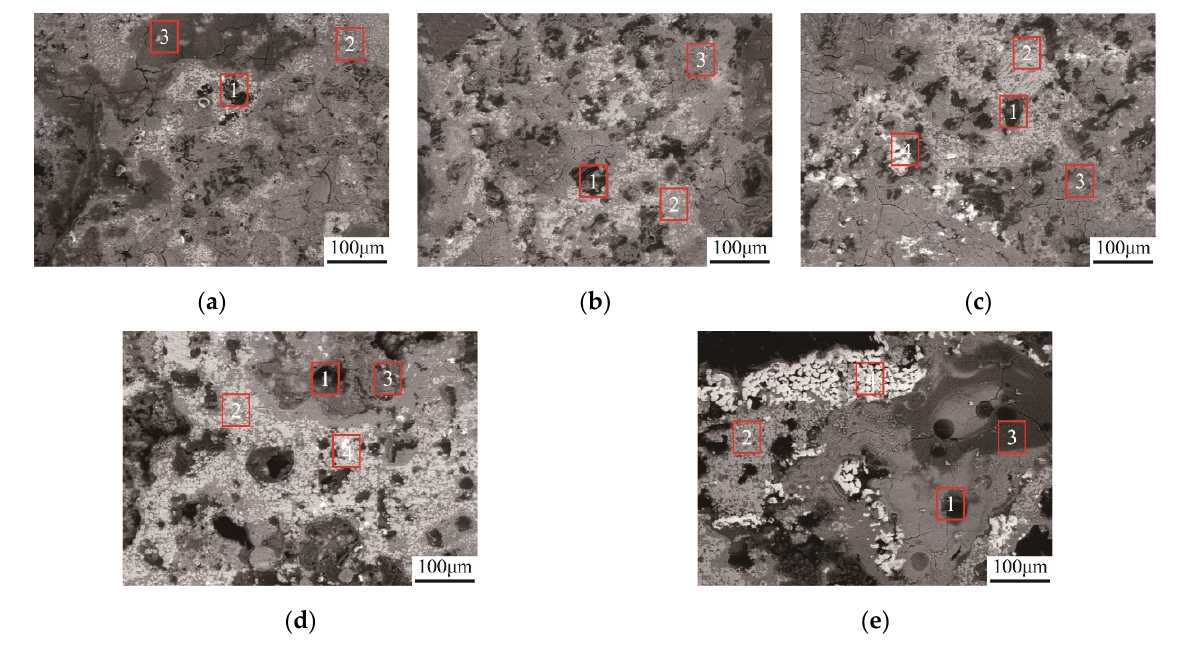
Figure 6. Changes in morphology of reduction products with time: ( a ) 15 min, ( b ) 30 min, ( c ) 40 min, ( d ) 50 min, ( e ) 60 min; (1) hollow region, (2) light white region, (3) dark gray region, (4) bright white region.